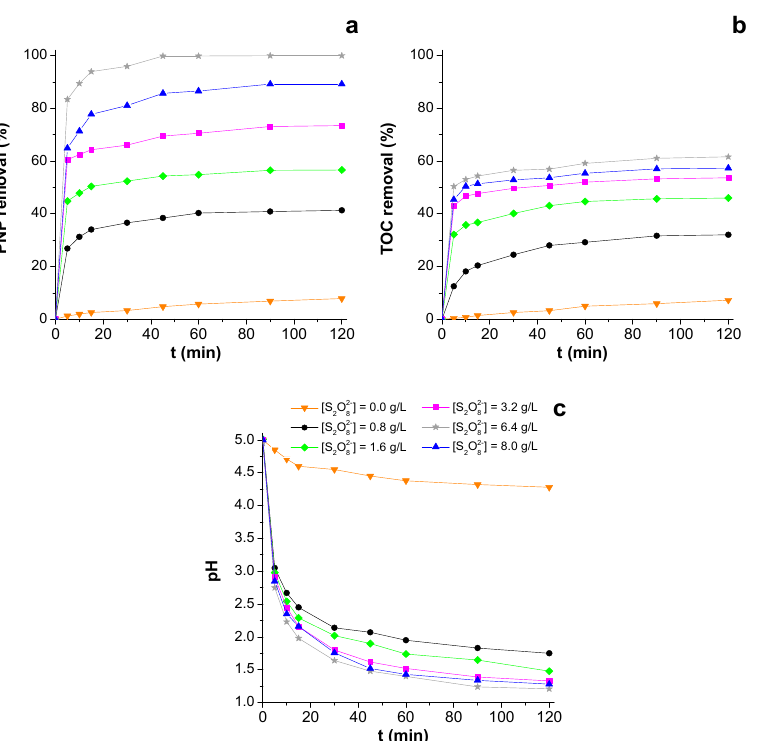
Figure 3. Effect of persulphate concentration on PNP ( a ) and TOC ( b ) removals and pH evolution ( c ) during the oxidation process ([PNP] o = 500 mg/L, pH = 5.0, T= 70 °C and I = 500 W/m 2 ).